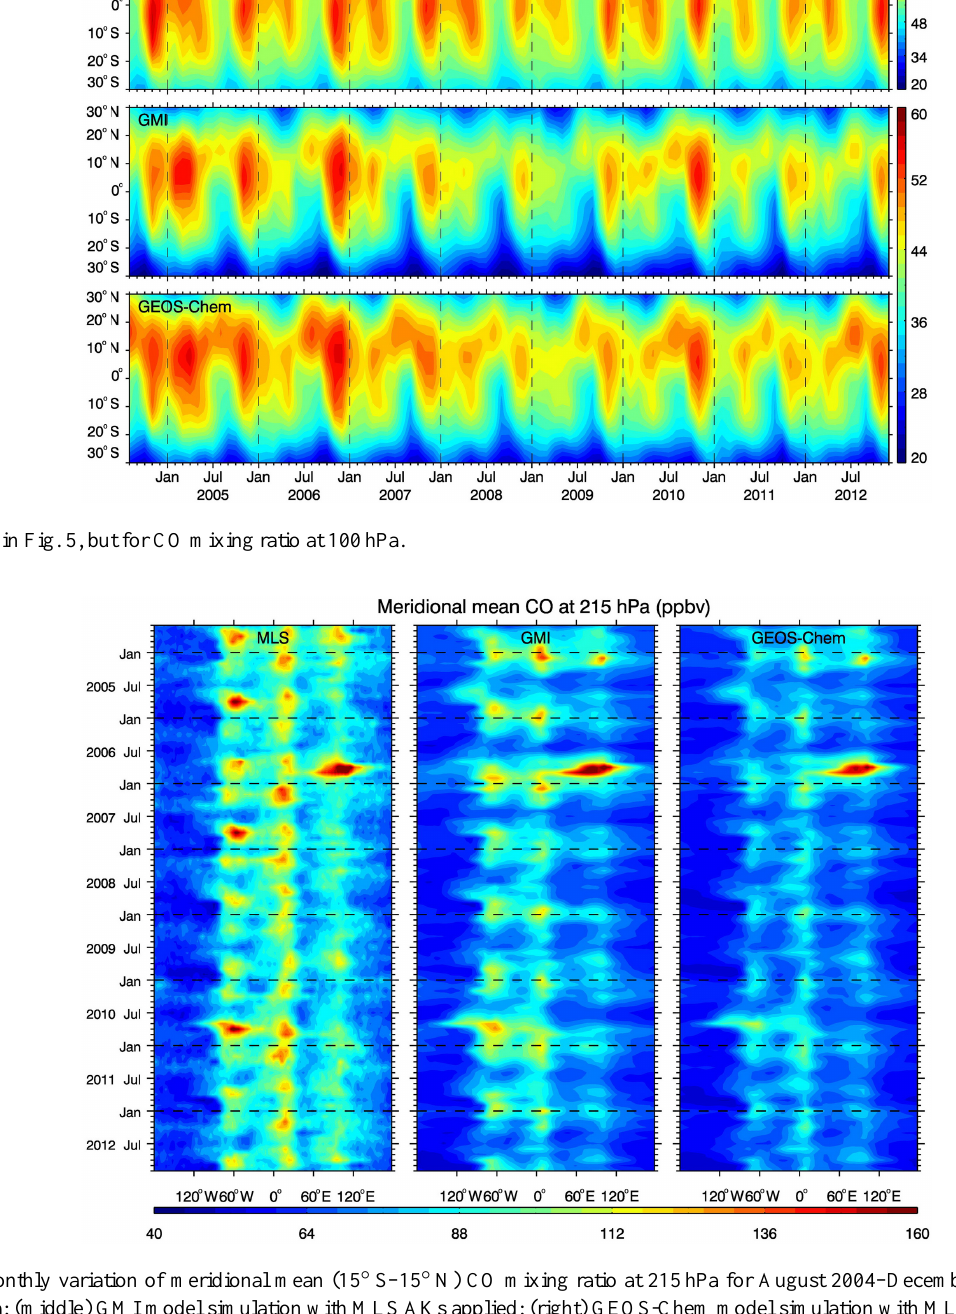
Figure 7. Monthly variation of meridional mean (15 ◦ S–15 ◦ N) CO mixing ratio at 215hPa for August 2004–December 2012 from (left) MLS V4 data; (middle) GMI model simulation with MLS AKs applied; (right) GEOS-Chem model simulation with MLS AKs